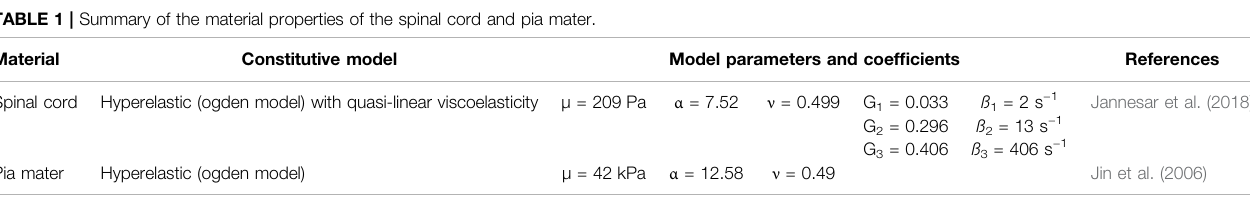
TABLE 1 | Summary of the material properties of the spinal cord and pia mater. Material Constitutive model Model parameters and coef fi